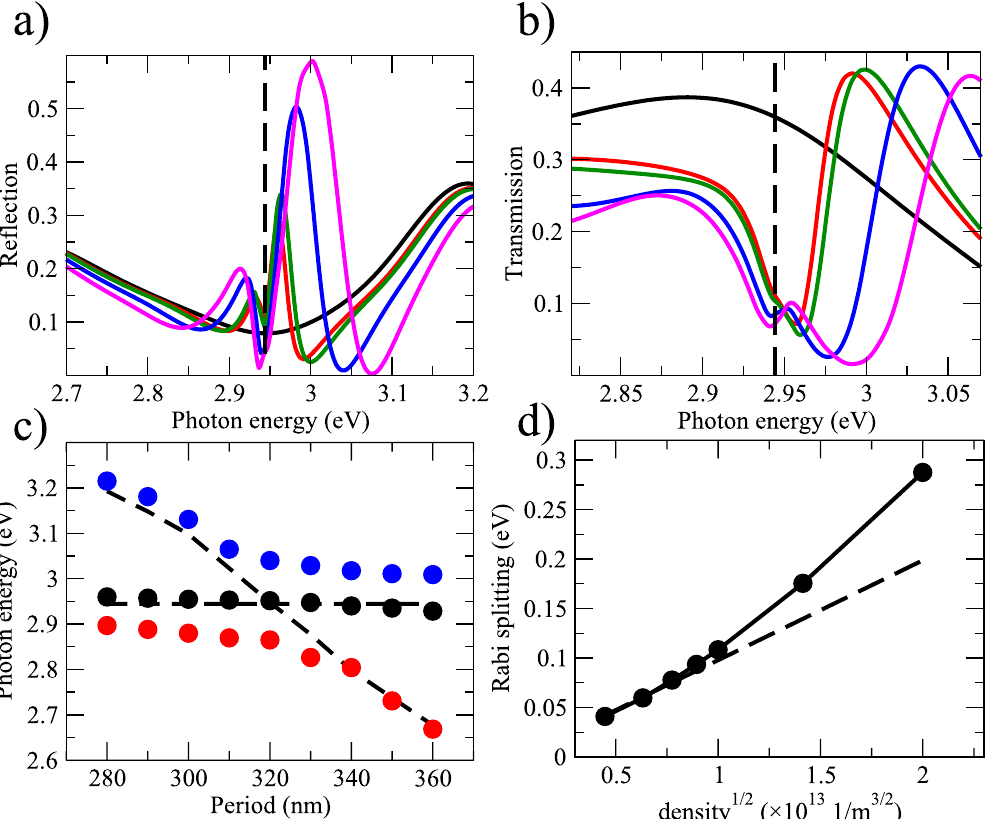
Figure 3. Results of numerical modeling I. Panels (a,b) show reflection and transmission as functions of the incident photon energy for the hybrid system comprising polystyrene spheres with a period of 320 nm covered by a silver film with a thickness of 50 nm and molecular layer with a thickness of 20 nm. Black lines show results for the bare opal array, red lines are for the the hybrid system at the molecular concentration of 8 × 10 25 m − 3 , green lines are for 10 26 m − 3 , blue lines are for 2 × 10 26 m − 3 , and magenta lines are for 3 × 10 26 m − 3 . Vertical dashed line in both panels indicates the molecular transition energy corresponding to the Bragg-plasmon mode for the array with a 320 nm period (2.94 eV). Panel (c) shows energies of the upper (blue circles) and lower (red circles) polaritons as functions of the period of the opal array at the molecular concentration of 2 × 10 26 m − 3 . The black circles indicate the position of the third mode extracted from transmission spectra. Horizontal dashed line shows the molecular transition energy. The curved dashed line shows the dependence of the Bragg-plasmon mode of the bare opal array on the period. Panel (d) shows the Rabi splitting as a function of the n , where n is the number density of molecules. The straight dashed line shows the expected n functional dependence. Other molecular parameters are: the transition dipole moment is d 0 = 10 Debye, the radiationless lifetime of the excited state is l ps, the pure dephasing time is 730